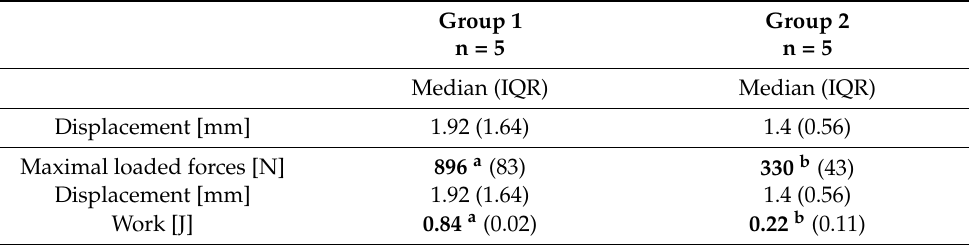
Table 1. Mean ± standard